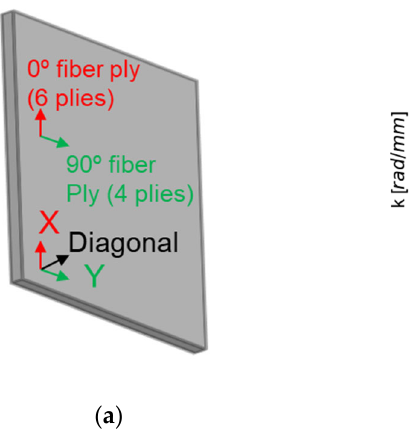
Figure 5. Semi-analytical finite element calculation modes (dispersion curves) in diagonal propaga- tion (identified in ( a )) in wavenumber (rad/mm) for the composite square plate used experimentally (2.63 mm of thickness–400 × 400 mm 2 ) ( b ).